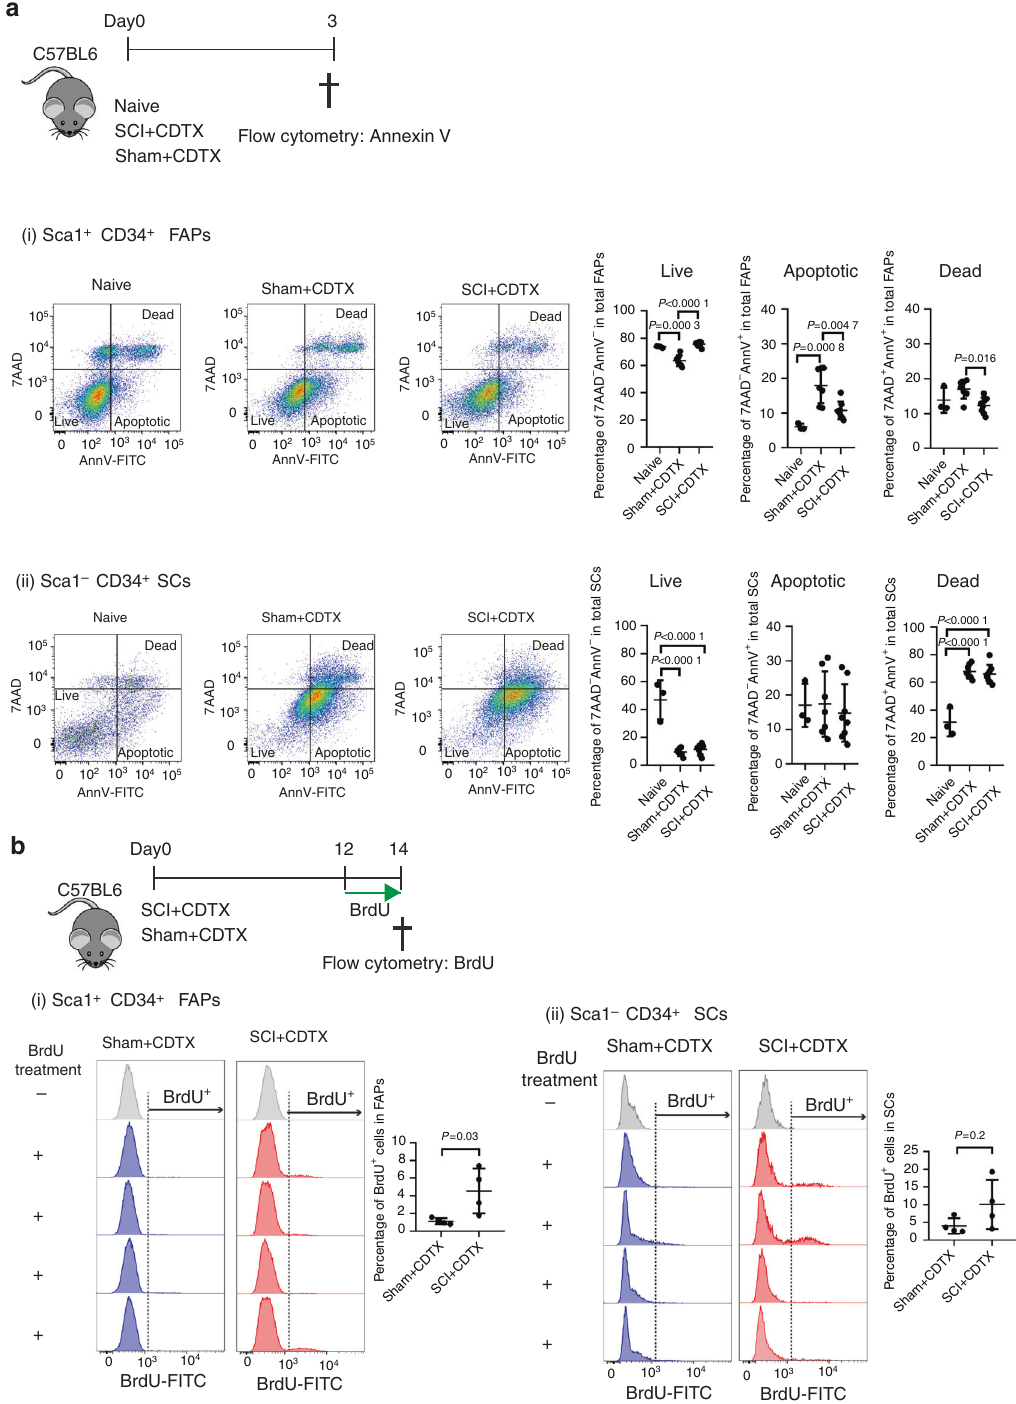
Fig. 5 SCI leads to decreased apoptosis and persistent proliferation of FAPs in injured muscles. a Naïve C57BL/6 mice underwent SCI or sham surgery plus intramuscular injection of CDTX. Muscle cells were isolated 3 days later. Apoptotic cells were subsequently analyzed by Annexin V (AnnV) and 7-amino-actinomycin D (7AAD) staining by fl ow cytometry. (i) CD45 Lin − CD31 − Sca1 + CD34 + ITGA7 − FAPs and (ii) CD45 Lin − CD31 − Sca1 − CD34 + ITGA7 + SCs were gated. AnnV and 7AAD staining further distinguished cells as live (7AAD − AnnV − ), apoptotic (7AAD − AnnV + ) and postapoptotic dead (7AAD + AnnV + ) in both FAP and SC populations. The percentages of live, apoptotic and dead cells in the total FAP or SC populations are presented as the mean ± SD ( n = 3, 7, and 8 in naïve, sham + CDTX, and SCI + CDTX, respectively). Each dot represents a separate mouse. Signi fi cance was calculated by one-way ANOVA with Tukey ’ s multiple comparison test. b C57BL/6 mice underwent SCI or sham surgery plus intramuscular injection of CDTX. Mice were given drinking water containing BrdU together with BrdU i.p. injection (twice daily) from day 12 to 14. One SCI + CDTX and 1 sham + CDTX mouse were not treated with BrdU and used as a negative control for anti-BrdU staining. On day 14, muscle cells were isolated, and BrdU staining was analyzed in CD45 Lin − CD31 − Sca1 + CD34 + ITGA7 − FAPs and CD45 Lin − CD31 − Sca1 − CD34 + ITGA7 + SCs by fl ow cytometry. The percentage of BrdU + cells in the total FAP or SC population is presented as the mean ± SD. Each dot represents a separate mouse. Signi fi cance was calculated by a two-sided Mann – Whitney